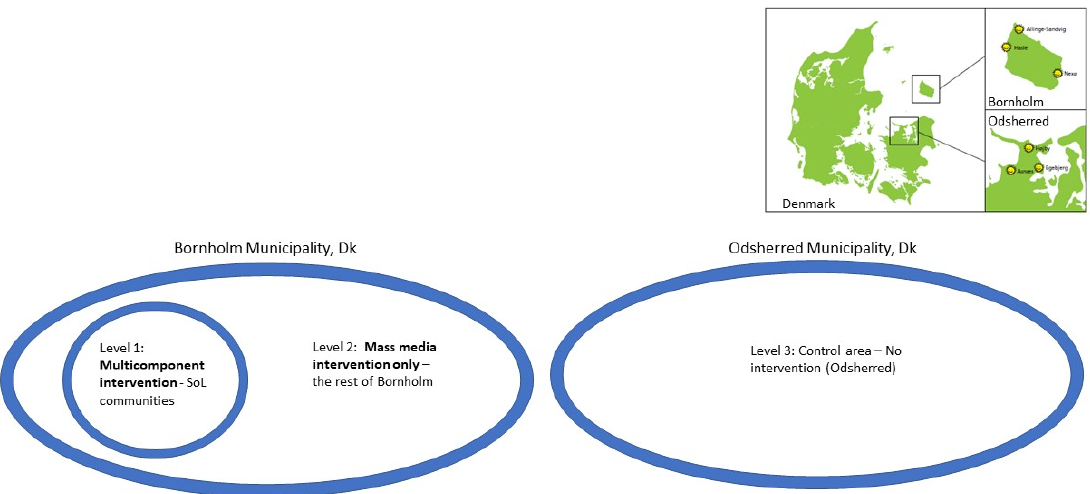
Figure 1. Evaluation design: comparing sales data for supermarkets in areas with a multi-component intervention (SoL communities), areas with mass media intervention only (the rest of Bornholm municipality) and the control area (no intervention, Odsherred municipality).